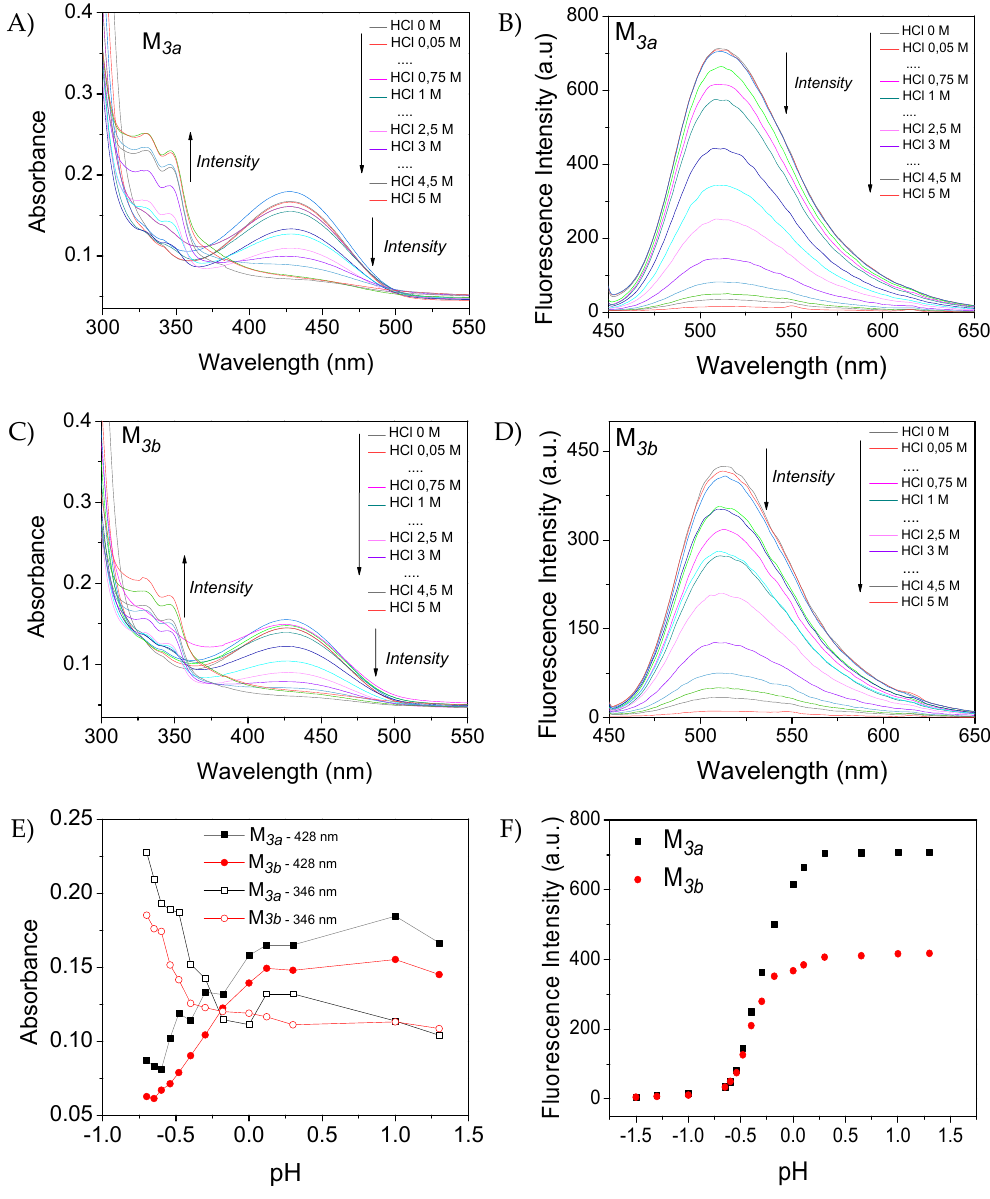
Figure 3. Absorption of M 3a ( A ) and M 3b ( C ) and fluorescence of M 3a ( B ) and M 3b ( D ) as a function of acid media. Comparison of the absorption ( E ) and fluorescence ( F ) changes with pH for M 3a and M 3b .